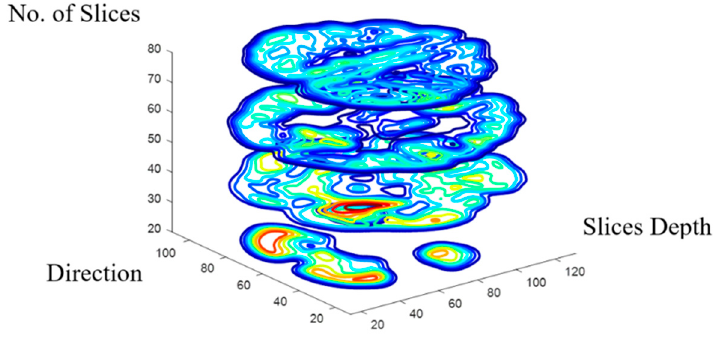
Figure 1. Slices of brain images by SPM12.